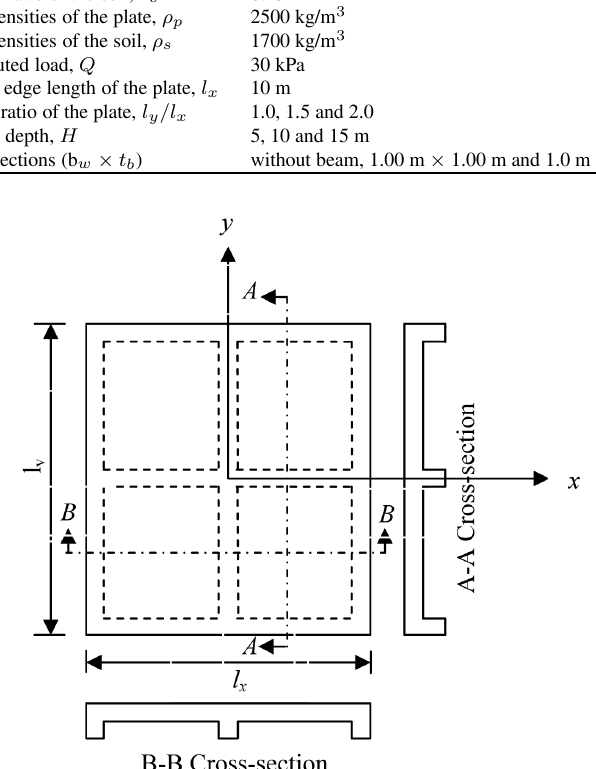
Fig. 5. Illustration of plate with